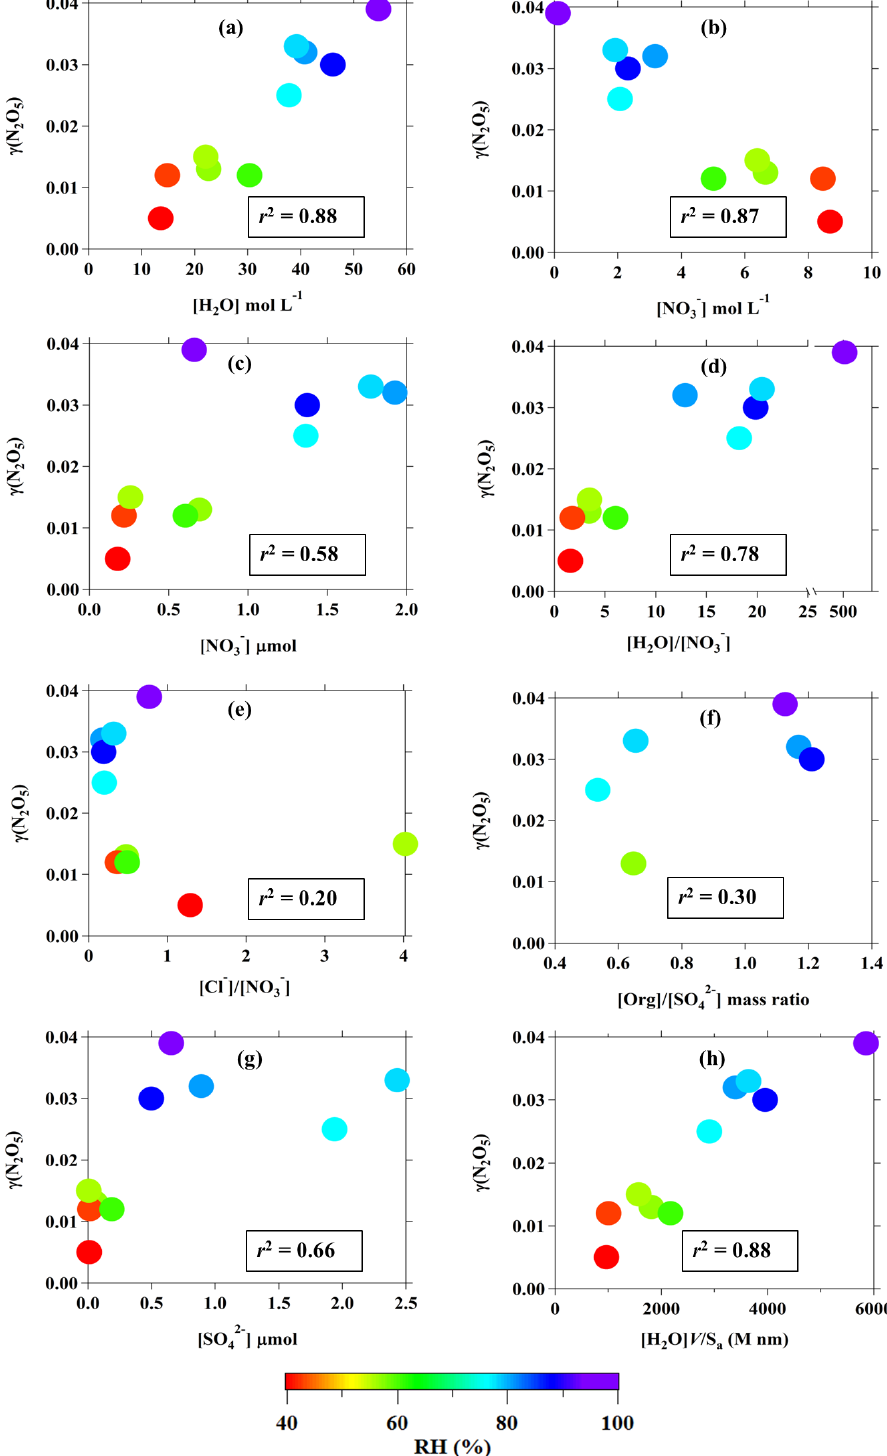
Figure 6. Relationship between field-derived γ (N 2 O 5 ) and (a) aerosol water content (mol per volume of aerosol); (b) nitrate concentration per volume of aerosol; (c) particulate nitrate concentration (µmolm − 3 of air); (d) H 2 O to NO − (f) organic-to-sulfate mass ratio (data from aerosol mass spectrometer); (g) concentration of SO 2 − water in aerosol multiplied by the volume-to-surface-area ratio. Color code represents the ambient RH, and the value in the box is the best correlation coefficient obtained from curve